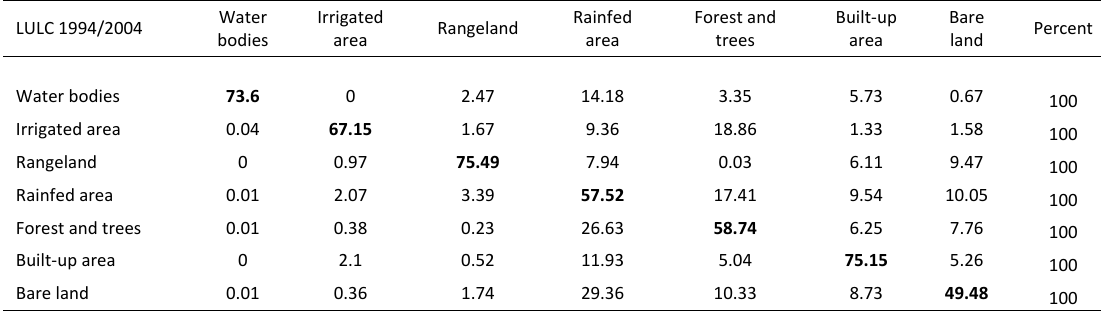
Table 6d: Transition area of each class for 1994-2004 (round two)